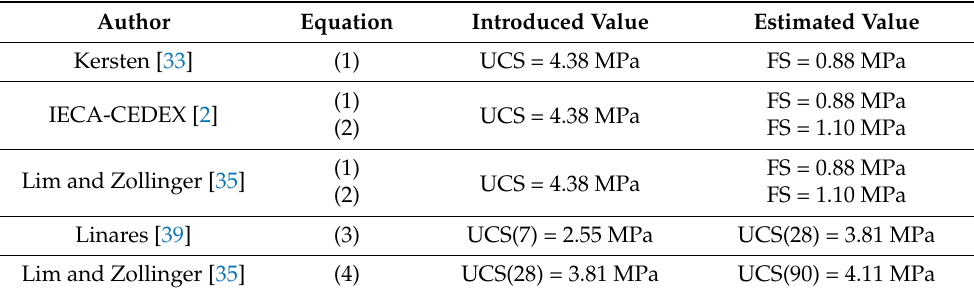
Table 11. FS and UCS values compared with other authors’ formulae 1